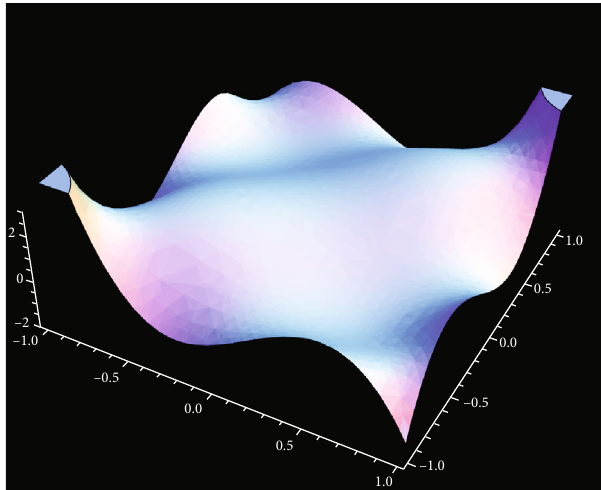
Figure 1: Reproducing kernel R